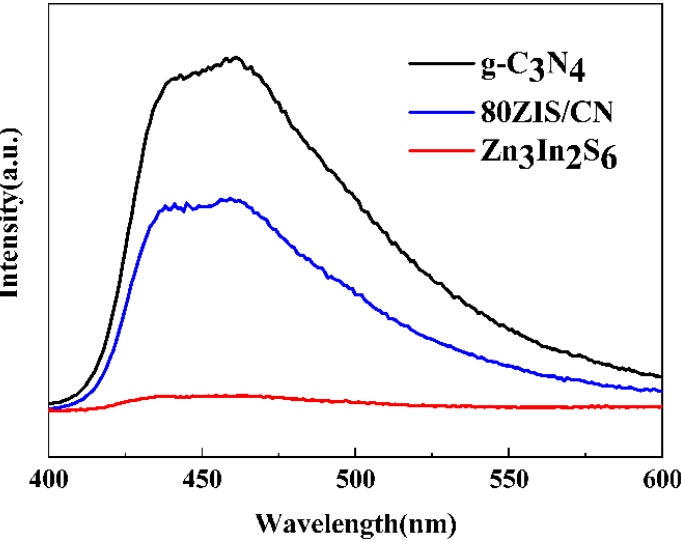
Figure 4. PL spectra: g ‐ C 3 N 4 nanosheets, Zn 3 In 2 S 6 and binary 80ZIS/CN heterojunction.